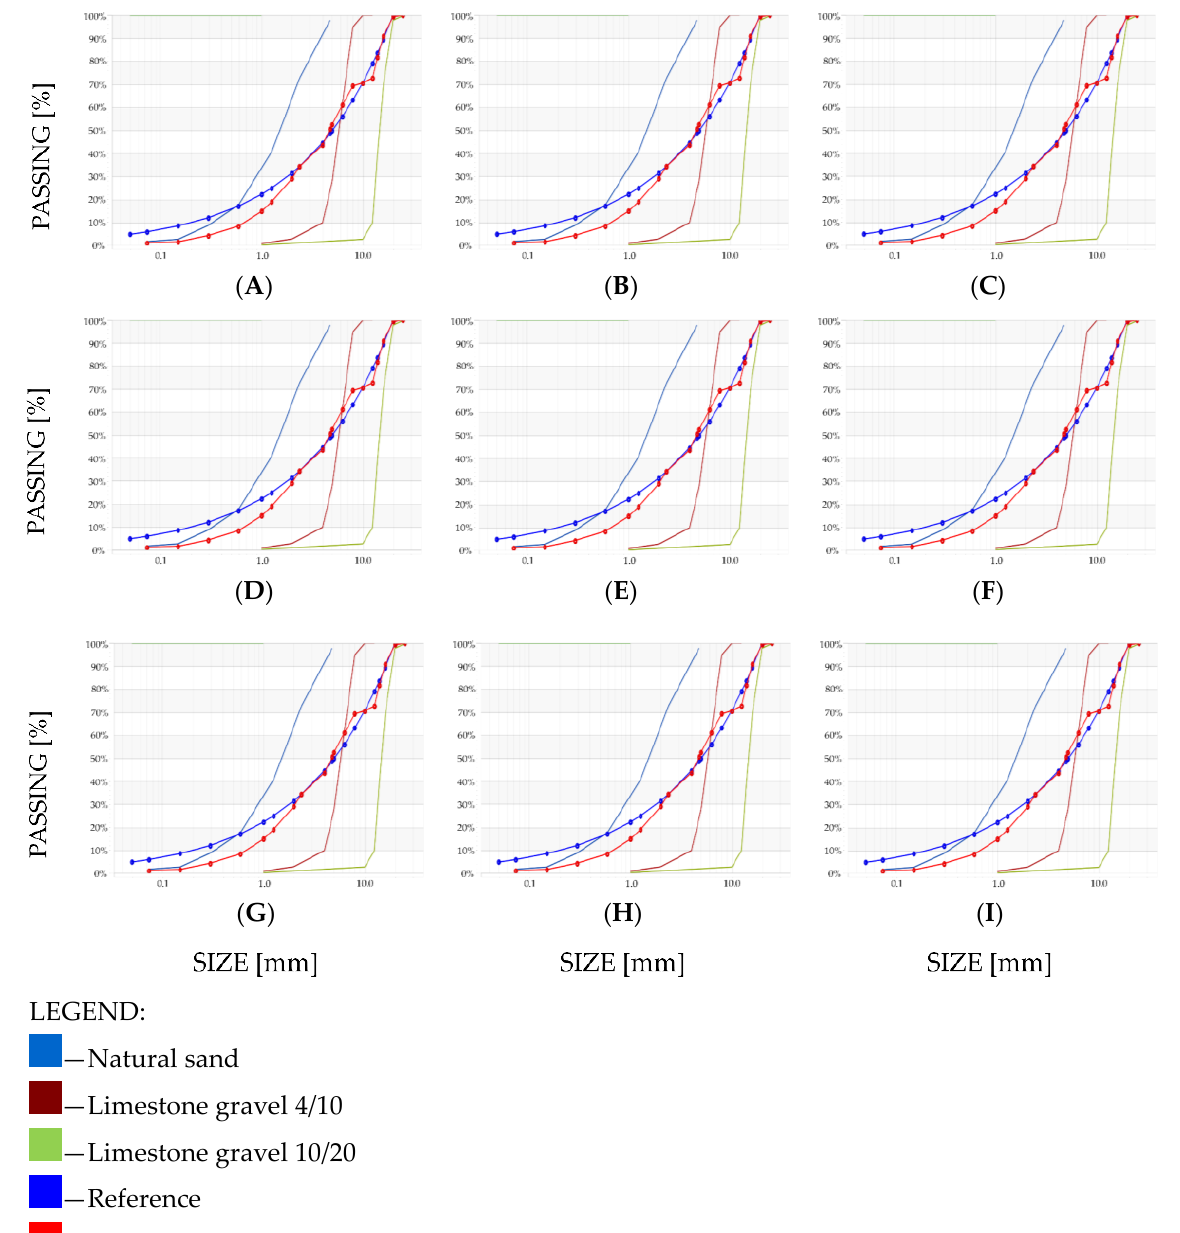
Figure A4. Gradings and fitting curves for Recipe #2—standard mix with plasticizer (lignosulfonate), superplasticizer (polycarboxylate ether) and air entrainer (tensides) designed according to the Fuller Method: ( A ) 10 MPa; ( B ) 15 MPa; ( C )